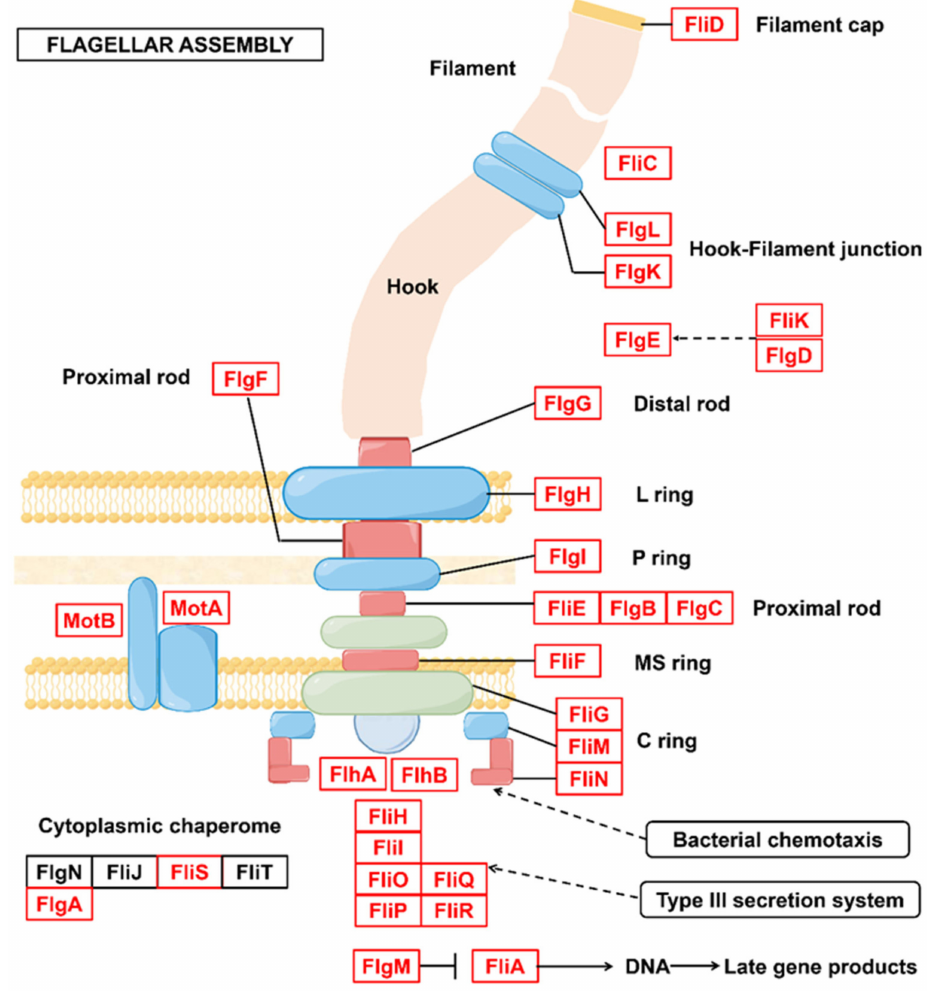
Figure 6. Sphingomonas sp. Flagellar assembly